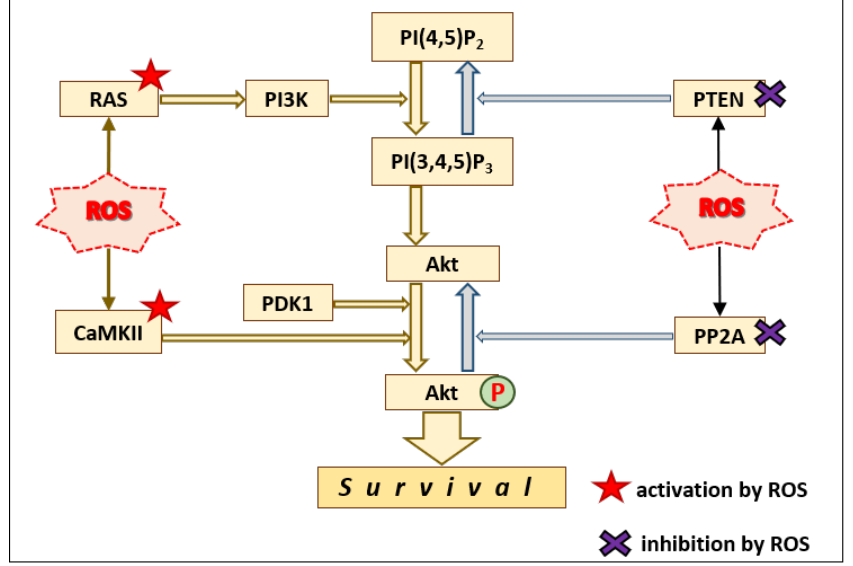
Figure 2. Potential mechanisms for indirect activation of the PI3K–Akt pathways by ROS-induced activation of Ras and CaMKII, as well as ROS-induced inhibition of PP2A.